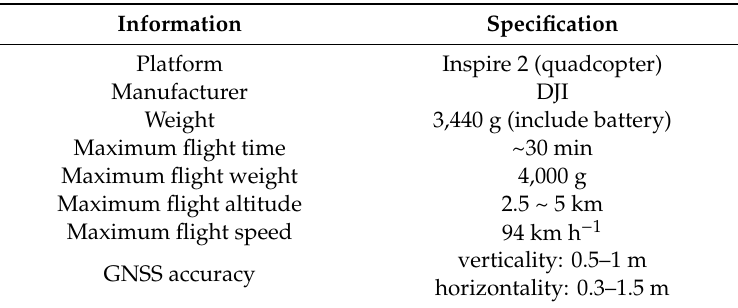
Figure 2. Low-altitude remote sensing system (LARS) observation system: ( a ) Inspire 2 (quadcopter); ( b ) multispectral cameras; and ( c ) global navigation satellite system (GNSS) and downwelling light sensor (DLS). Table 2. Inspire 2 (quadcopter) specifications.